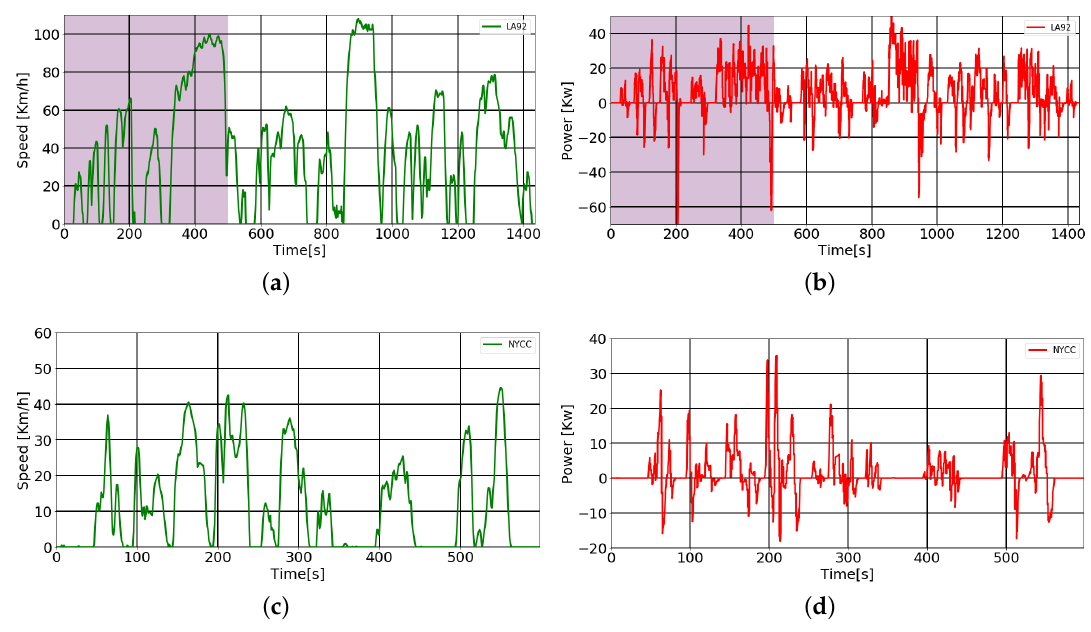
Figure 9. The velocity profiles and power profiles of representative standard driving cycles LA92 dynamometer driving schedule (LA92) and the New York City Cycle (NYCC). ( a ) The speed profile of LA92; ( b ) the power profile of LA92; ( c ) the speed profile of NYCC; ( d ) the power profile of